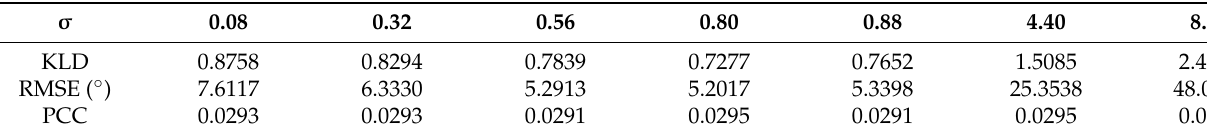
Table 3. Sensitivity analysis of parameter σ .